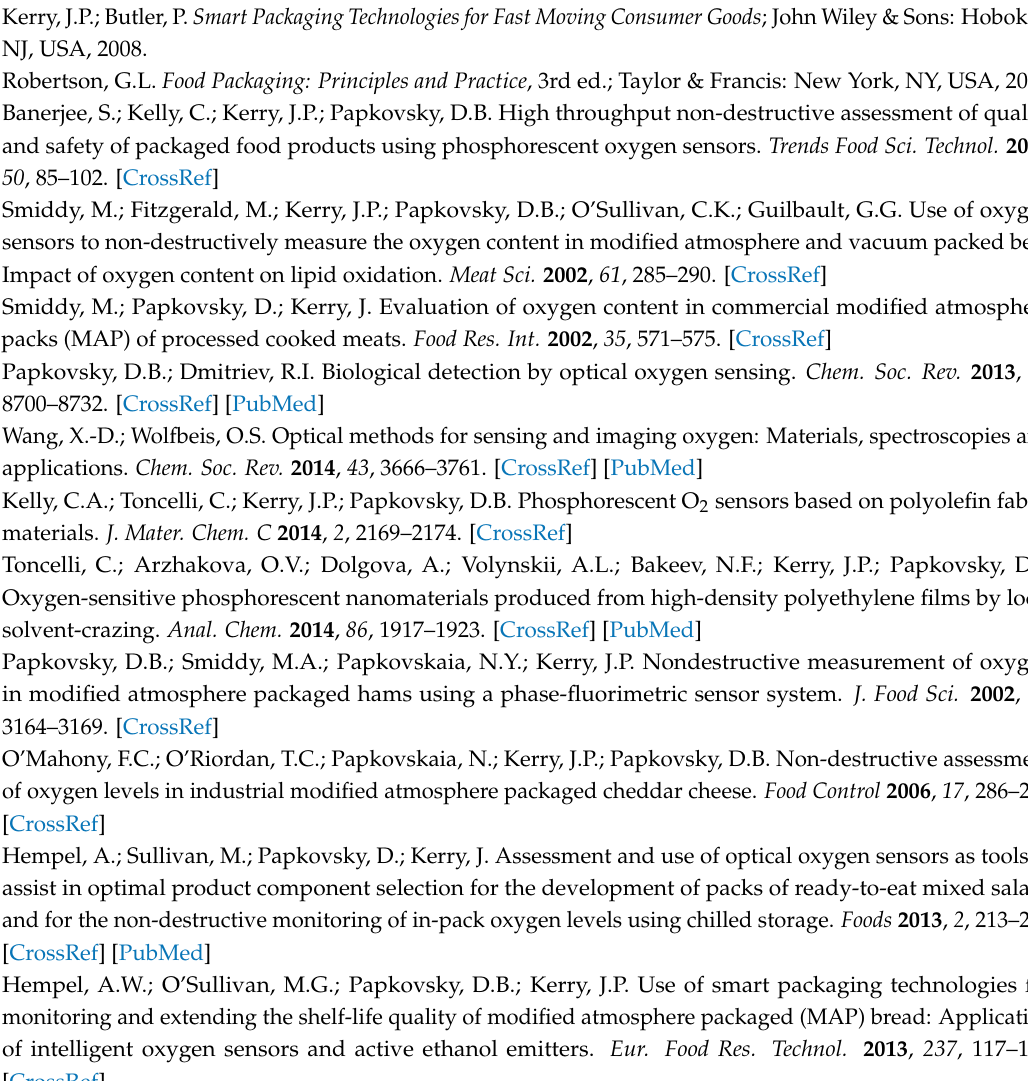
s1, Figure S1: Measurement of O 2 with Optech sensors at 1 ◦ C. ( A ) Readings from 8 individual sensors under standard experimental conditions (1 ◦ C, 20.86% O 2 ) produced with an Optech-O 2 Platinum reader calibrated with CalCard at 1 ◦ C. ( B ) O 2 readings from the same sensors measured at 1 ◦ C (blue bar) and 22 ◦ C (orange bar). Mean O 2 values are 20.6 ± 0.8 and 21.0 ± 0.5, respectively. Calculated p-value of 0.12 shows that the difference is not significant ( p > 0.05, N = 8). Temperature readings at 1 ◦ C were 1.7 ± 1.0 ◦ C, and at 22 ◦ C–22.0 ± 0.1 ◦